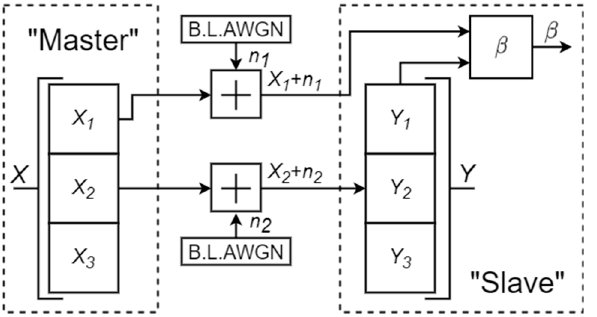
Figure 3. Block diagram of the experimental study of the noise immunity of chaos oscillator’s syn- chronization [16]. synchronization